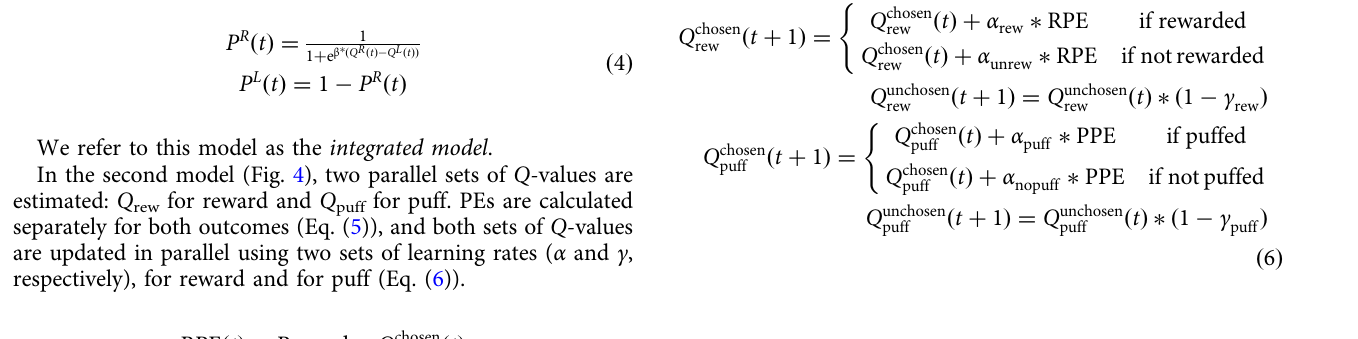
In the second model (Fig. 4), two parallel sets of Q -values are estimated: Q rew for reward and Q puff for puff. PEs are calculated separately for both outcomes (Eq. (5)), and both sets of Q -values are updated in parallel using two sets of learning rates ( α and γ , respectively), for reward and for puff (Eq. (6)).